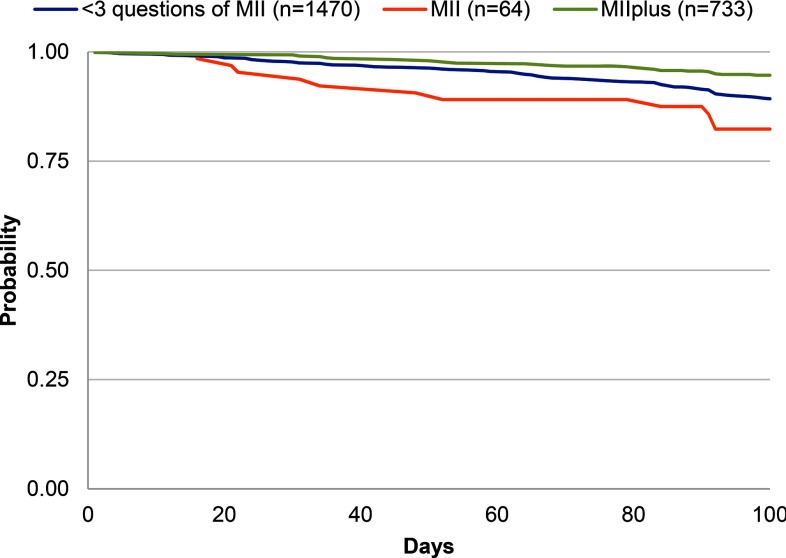
Kaplan-Meier Survival Curves of Contraceptive Continuation by MII With the Added Question About Method Switching (MIIplus) VariationAbbreviation: MII, Method Information Index.